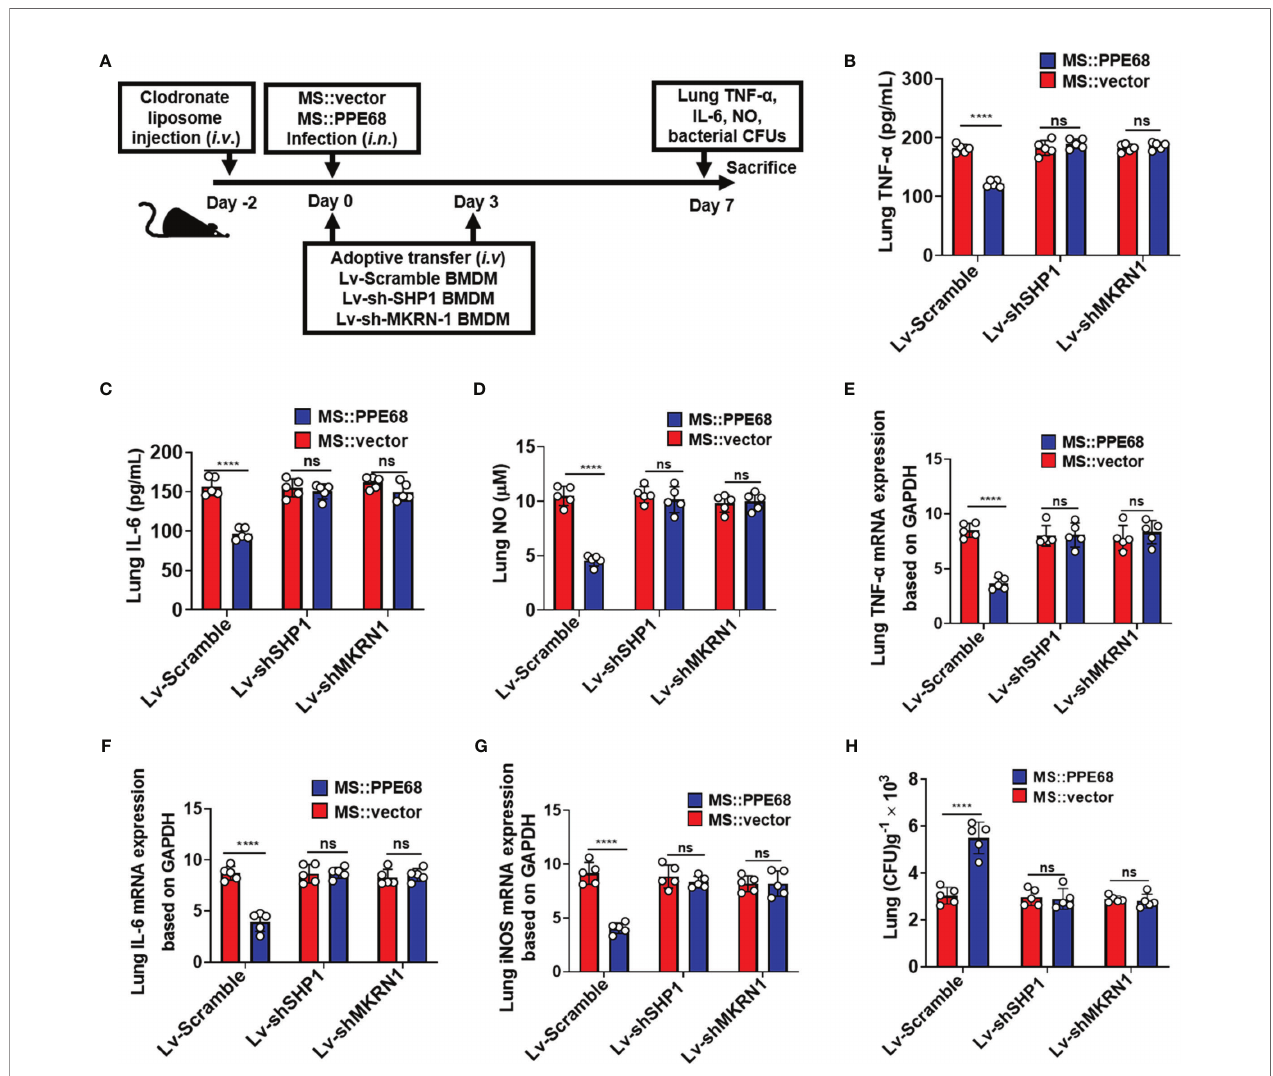
FIGURE 6 | Adoptive transfer of SHP1/MKRN1 knockdown macrophages attenuates the PPE68-mediated suppression of in fl ammatory cytokine expression and promotion of bacterial survival in mice. (A) Procedure for the macrophage adoptive transfer experiment. (B-D) Lung TNF- a (B) , IL-6 (C) and NO (D) levels were evaluated by ELISA in the mouse adoptive transfer experiments. (E-G) RT-qPCR analysis of lung TNF- a (E) , IL-6 (F) and iNOS (G) mRNA expression in the MS:: vector- or MS::PPE68-infected mice after adoptive transfer. (H) Mouse lung bacterial burden was determined by CFU counting on 7H10 agar plates (n = 5, each group). The data are expressed as the mean ± SD of three independent experiments for B-H, and two tailed unpaired t test was used to calculate statistical signi fi cance. p > 0.05, not signi fi cant (ns); **** p <